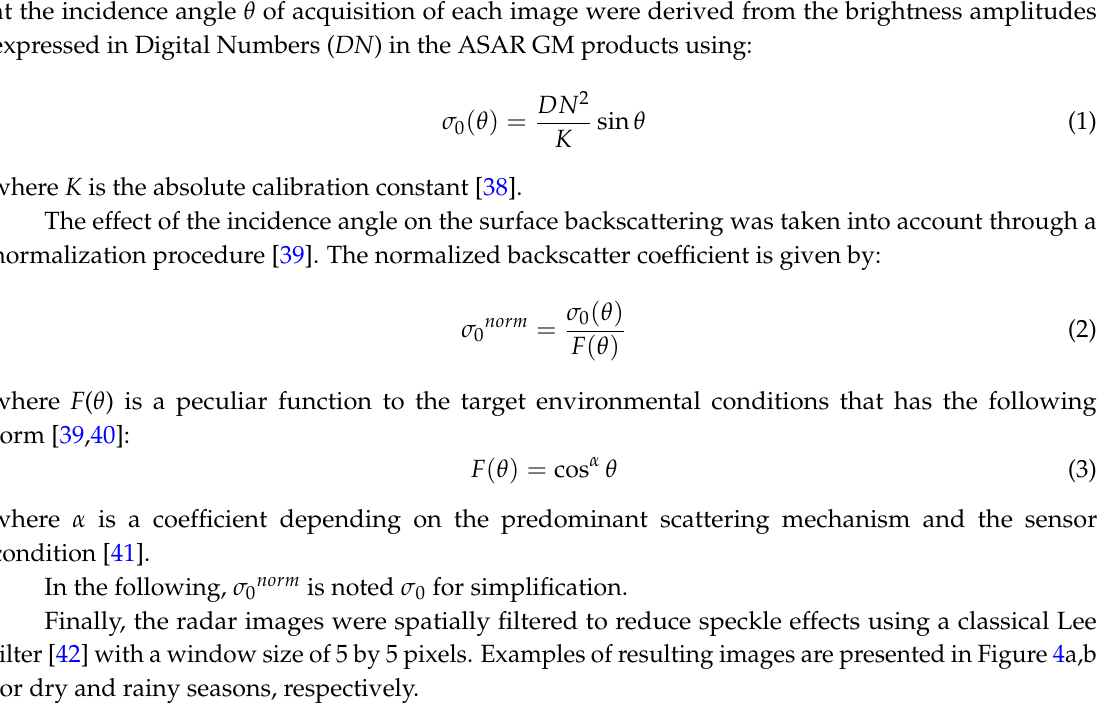
The change detection method used to identify flooded pixels during the wet season requires a well ‐ defined initial state corresponding to the backscattering during the dry season. It is necessary to